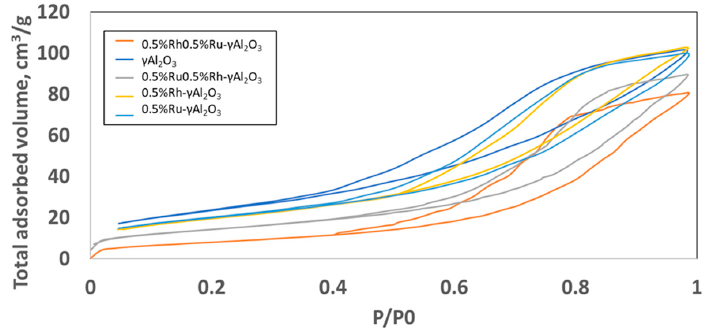
Figure 2. Catalysts’ adsorption–desorption isotherms compared with the bare γ Al 2 O 3 spheres.